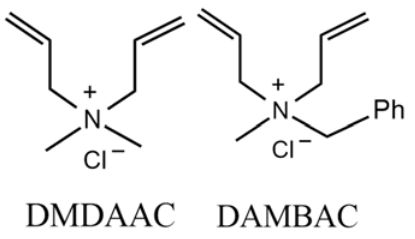
Figure 1. The structures of DMDAAC and DAMBAC.